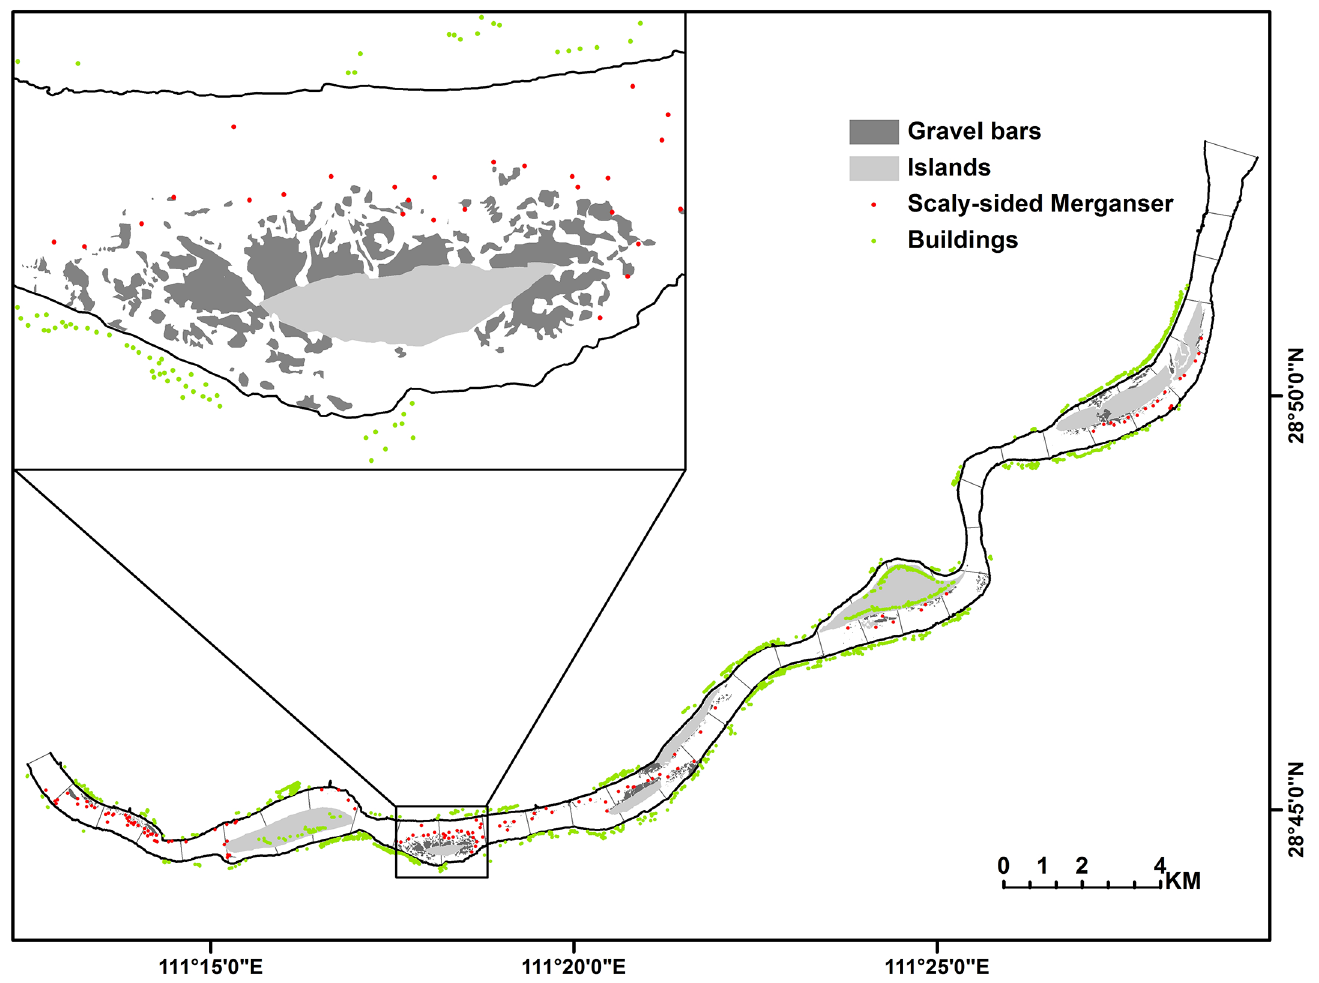
Fig 2. Distribution of Scaly-sided Merganser flocks and gravel bar patches in the 36 km river section of the lower Yuanjiang River. The red dots indicate 127 Scaly-sided Merganser flocks recorded over three winters.Green points represent houses along the river within a 50 m buffer zone. Areas in dark grey are gravel bars in river and area in light grey are